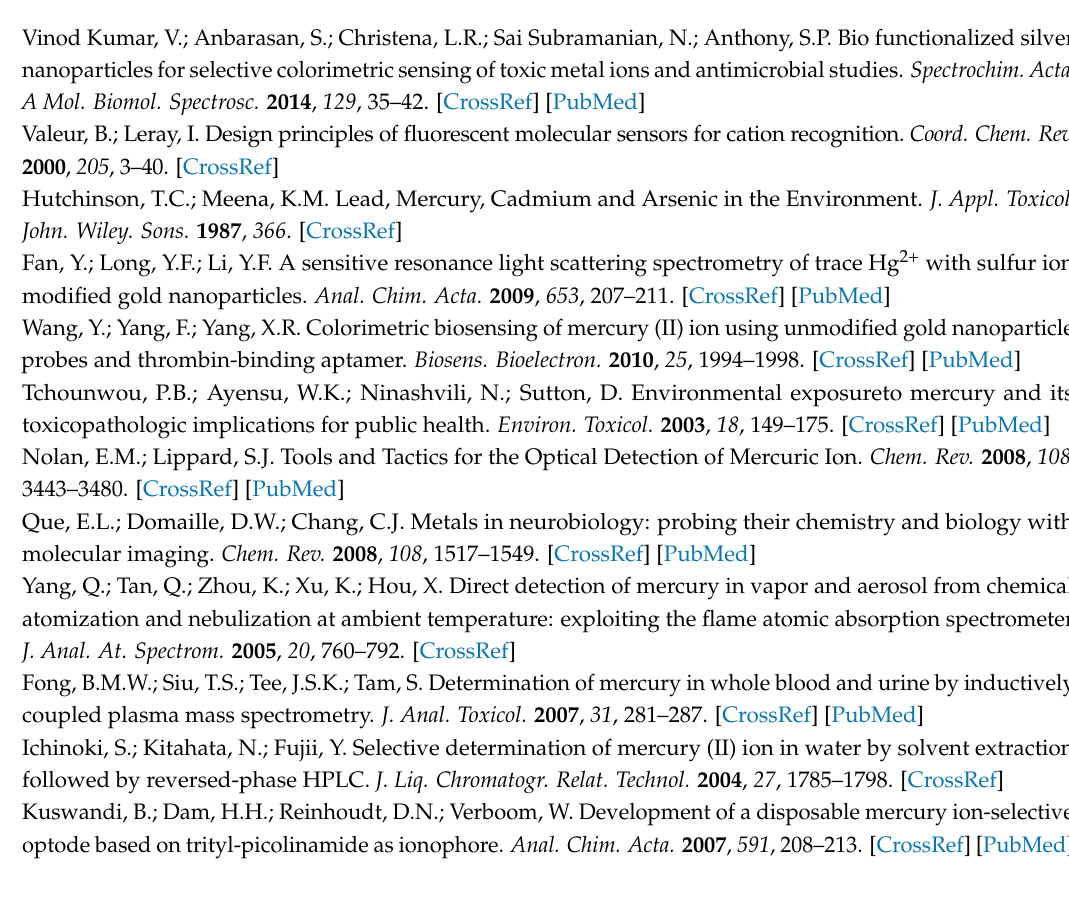
s1, Figure S1. FT-IR spectrum of ADP-AgNPs-Hg 2+ complex, Figure S2. Digital image of selectivity of ADP-AgNPs against various metal ions. Figure S3: Images showing the interaction of Hg 2+ with nitrogen atoms of APD-AgNPs ring in different orientations ( a and b